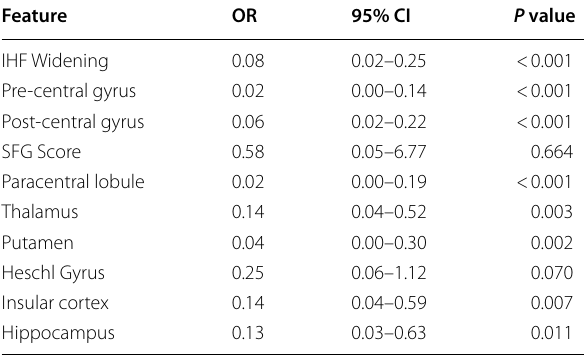
Table 8 Factors associated with MPI compared to other subtypes with reference being the severe grade of substrate